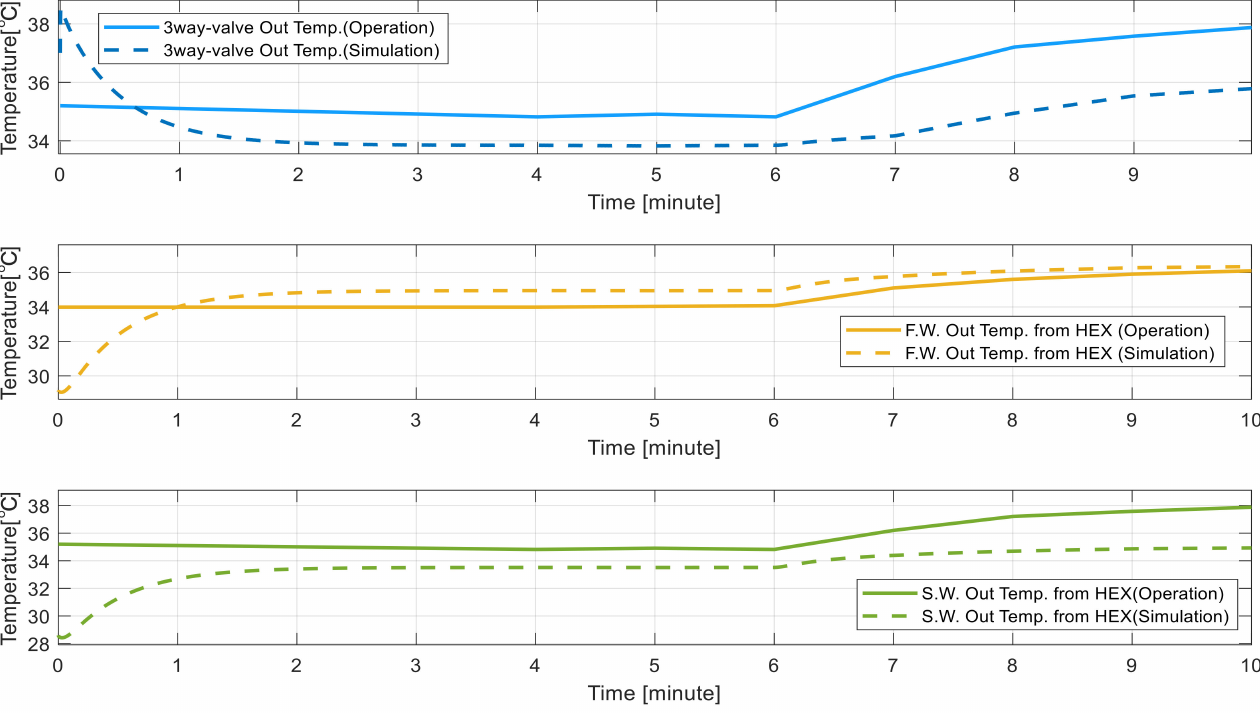
Figure 15. Comparison of operation data and simulation results on step down